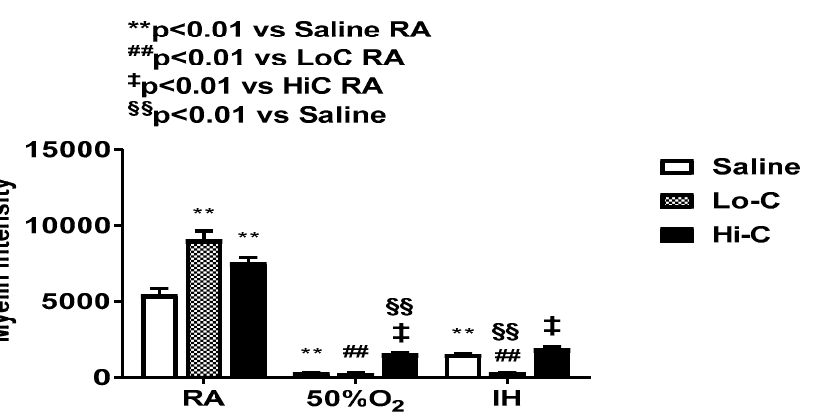
Figure 12. Quantitative analysis of myelin stains presented in Figure 10. Groups are as described in Figure 1. A two-way ANOVA was conducted to examine the effects of oxygen environment (factor 1) and treatment (factor 2) with Dunnett’s 2-sided multiple comparison post hoc test. Saline was used as the control for the treatment groups within each oxygen environment; and room air (RA) was used as the control among the oxygen groups for each treatment. F(4,99) = 20.475, p < 0.01. ** p < 0.01 vs. Saline RA; ## p < 0.01 vs. LoC RA; ‡ p < 0.01 vs. HiC RA; and §§ p < 0.01 vs. Saline in each oxygen environment. Data are presented as mean ± SEM ( n = 12 measurements/group).